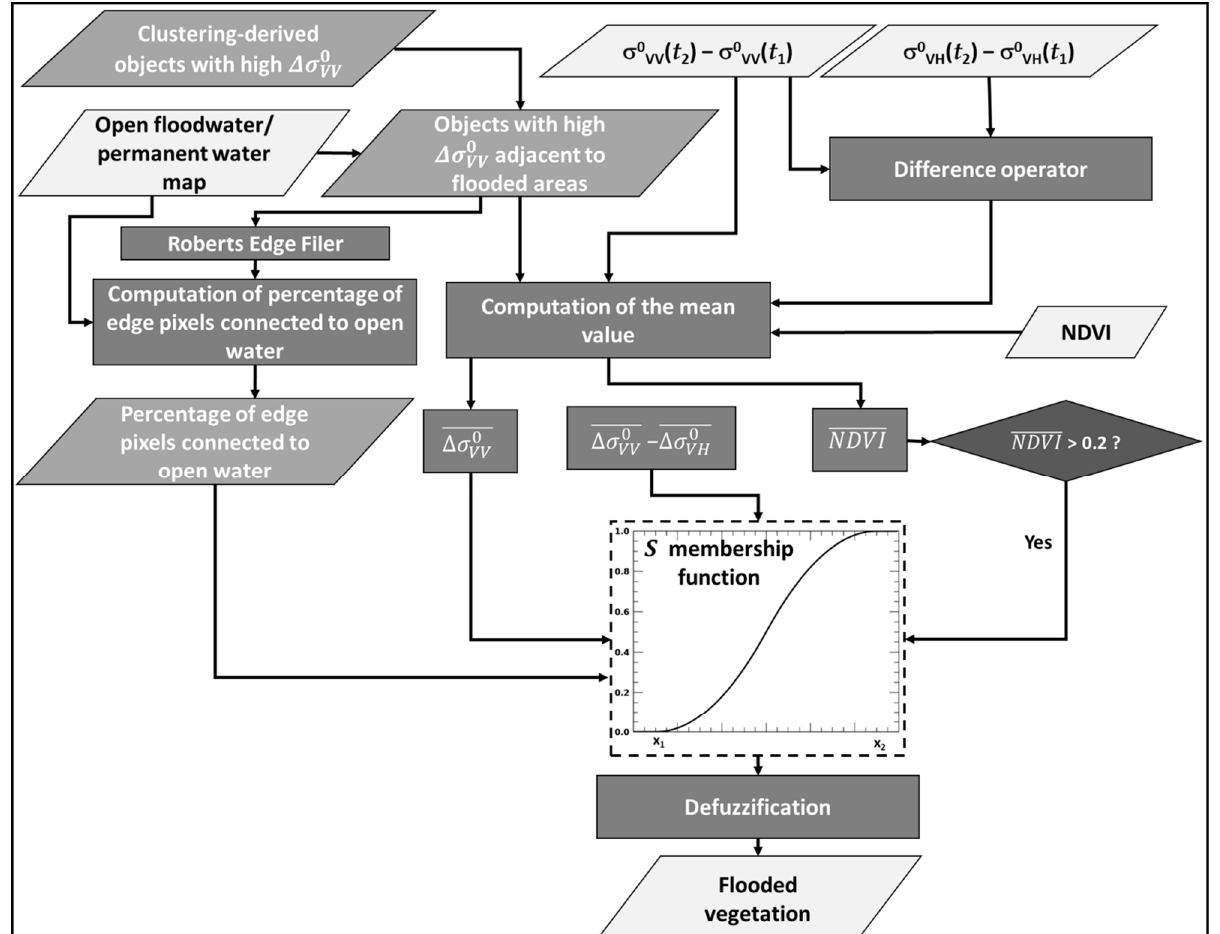
Figure 11. Flowchart of the algorithm developed to map flooded vegetation implemented in AUTOWADE. Dark gray rectangles represent operations; parallelograms represent data (light gray: input/output data, dark gray: intermediate data).